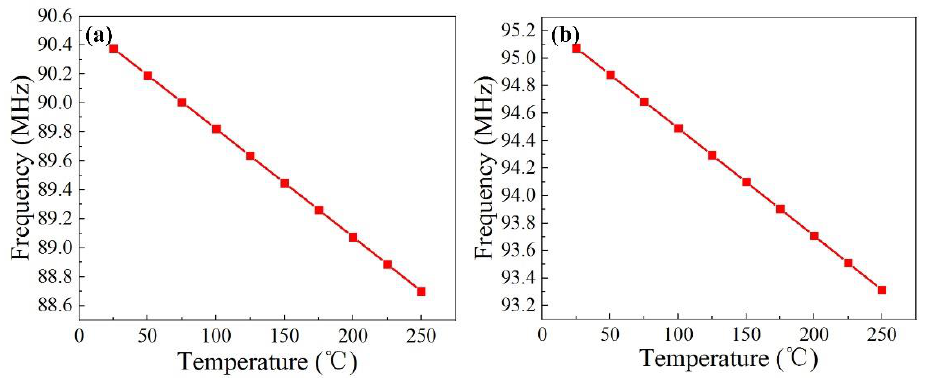
Figure 1. Simulation results of sensor temperature. ( a ) Response of temperature sensor to temperature. ( b ) Response of strain sensor to temperature.